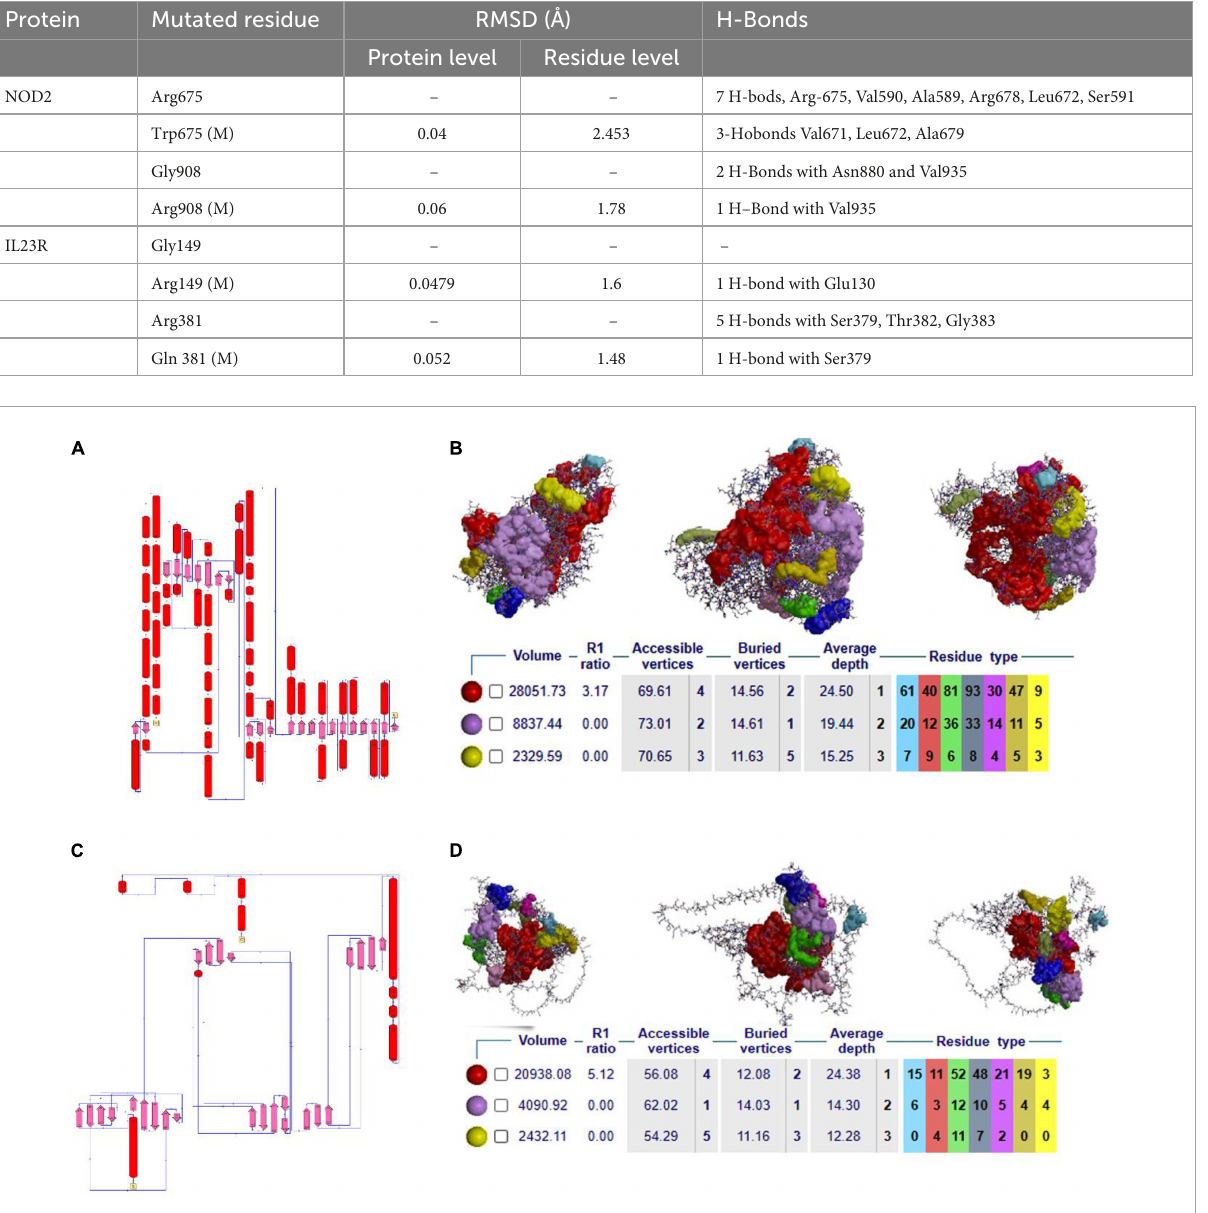
TABLE 2 RMSD values and H-bond interaction of mutant and wild type models of NOD2 and IL23R . Protein Mutated residue RMSD